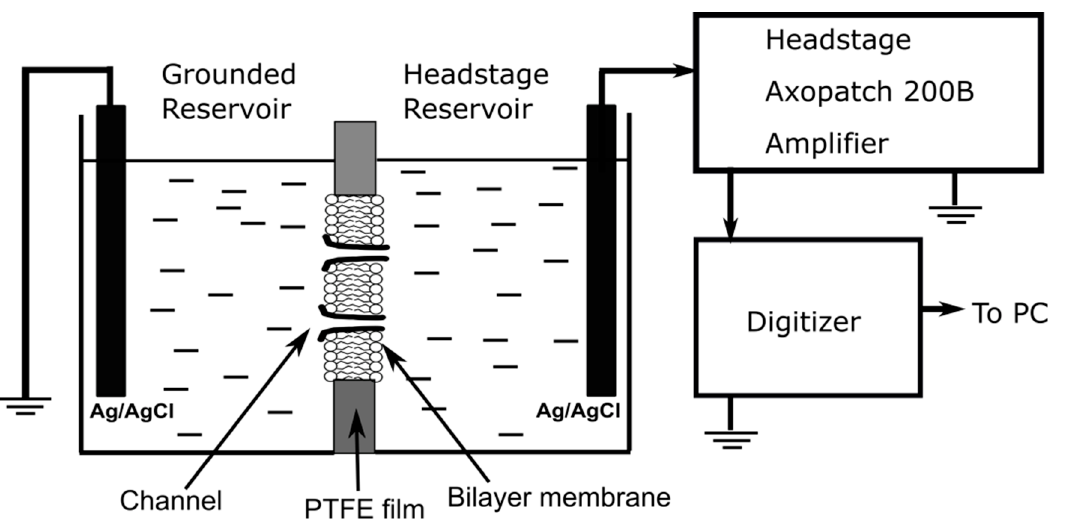
Figure A1. A typical experimental setup for lysenin channel reconstitution into bilayer lipid membranes and electrical measurements of changes in ionic currents induced by interactions with analytes.